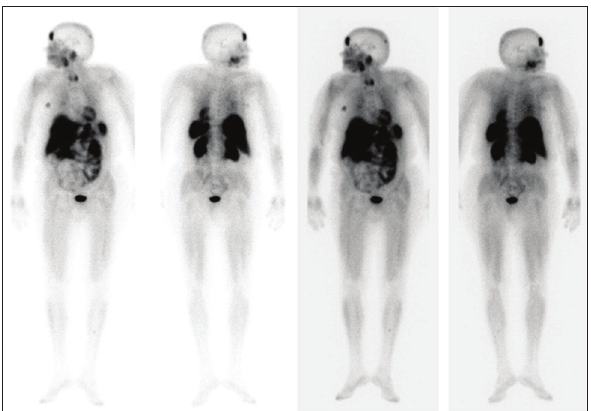
Fig. 2. 99mTc-MIBI scintigraphy. Whole-body planar scintig- raphy (anterior and posterior views) showed focal pathological accumulation of the radiopharmaceutical in the frontal and, less significantly, occipital skull. 99mTc-MIBI is accumulated in an area of osteolysis in the frontal region, suggesting myeloma relapse.